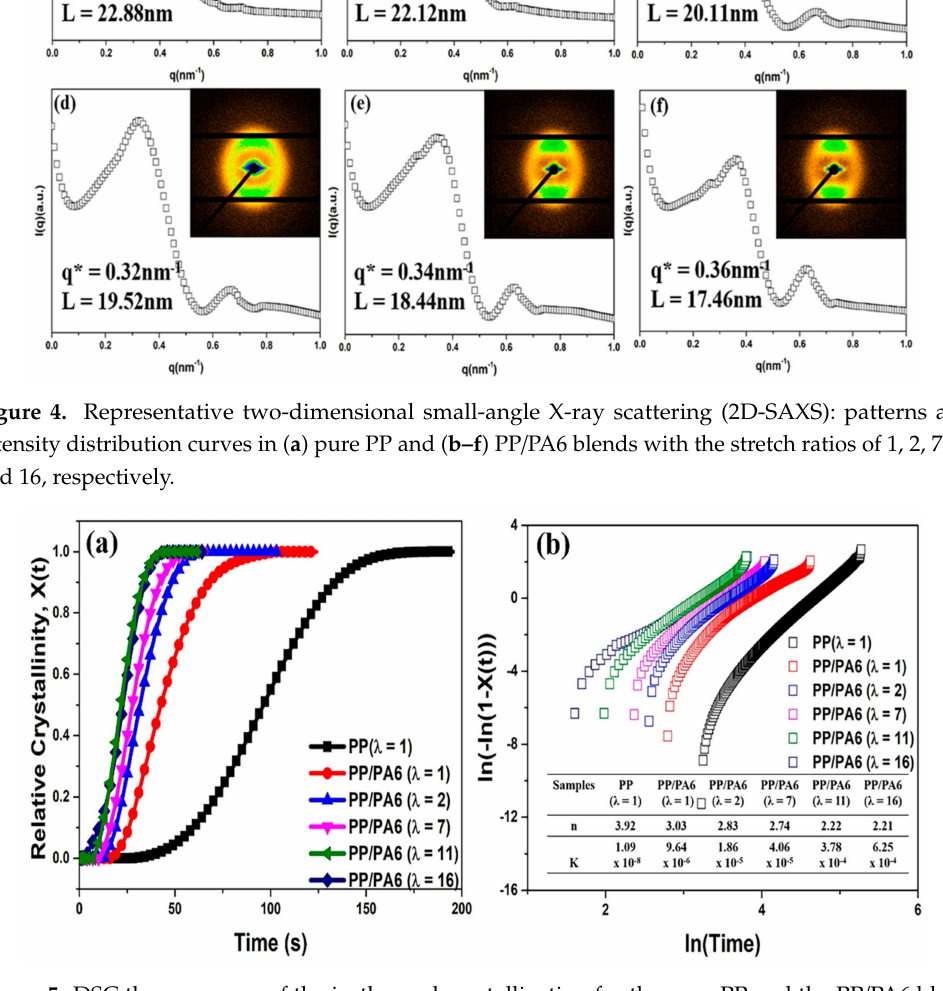
Figure 5. DSC thermograms of the isothermal crystallization for the pure PP and the PP / PA6 blend with the stretch ratios of 1, 2, 7, 11 and 16 at 125 ◦ C: ( a ) Relative crystallinity, X ( t ), as a function of the crystallization time ( t ) calculated from DSC; ( b ) isothermal crystallization kinetics analyzed using the Avrami equation. The Avrami parameters, Avrami exponent ( n ) and crystallization rate constant ( K ), are summarized in built-in table of Figure